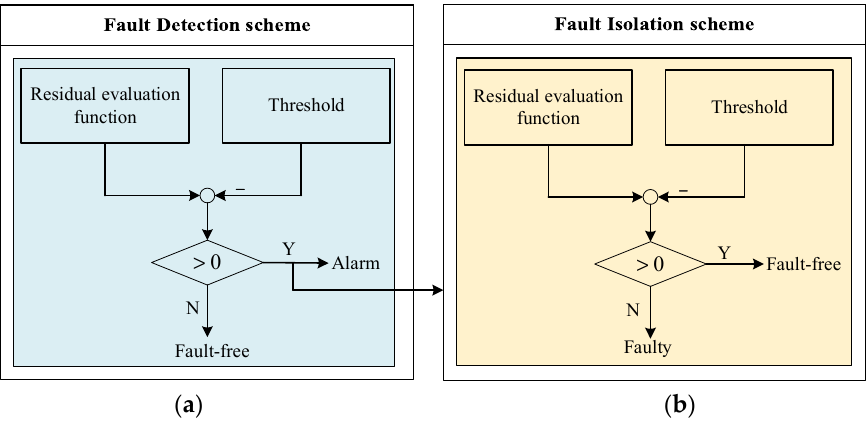
Figure 3. Fault detection and isolation schemes, where ( a ) represents fault detection scheme; ( b ) represents fault isolation scheme.